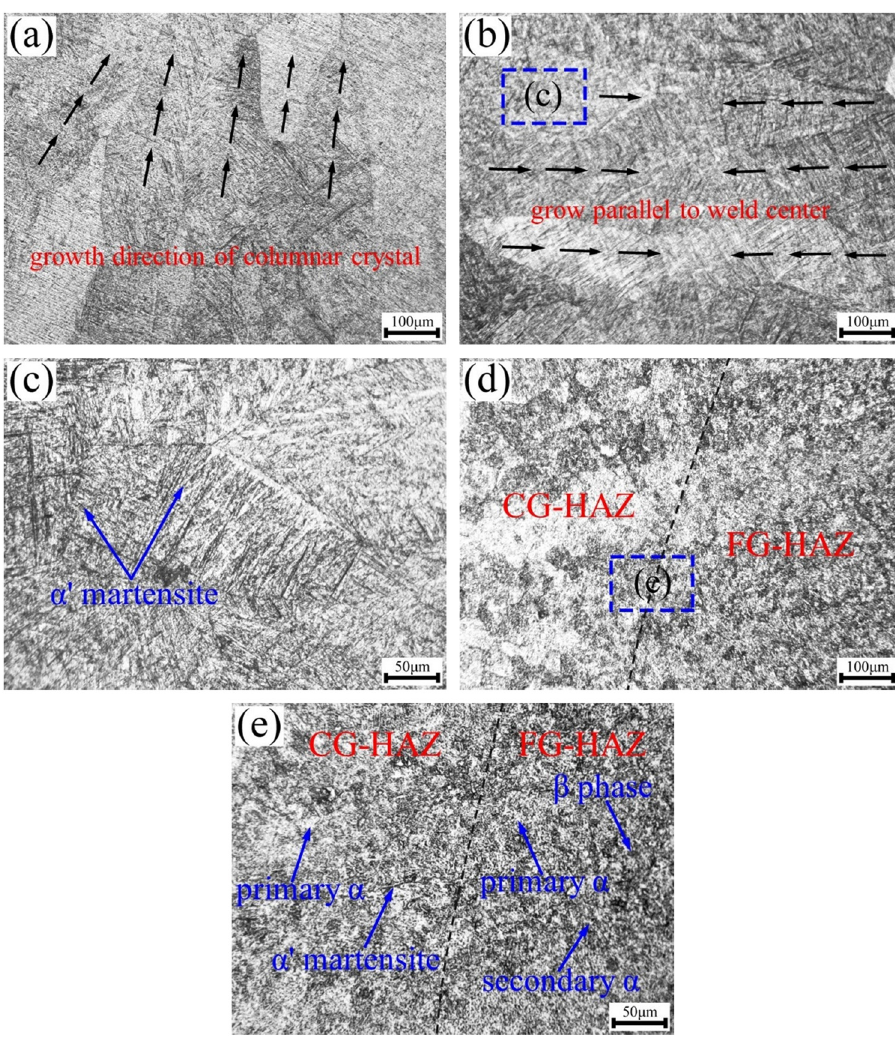
Figure 6: Microstructure of EBW joint: ( a ) the upper part of FZ, ( b ) the middle part of FZ, ( c ) magni fi cation of area c in ( b ) , ( d ) HAZ, and ( e ) magni fi cation of area e in ( d )